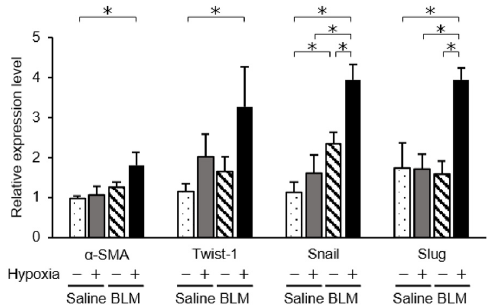
Figure 6. Expression of endothelial to mesenchymal transition markers determined by quantitative real-time PCR. mRNA levels of endothelial to mesenchymal transition markers were compared between endothelial cells from saline- and bleomycin-treated mouse lungs cultured under normoxic (20%) and hypoxic (1%) conditions. Quantitative real-time PCR was performed using three indepen- dently prepared cDNA samples from endothelial cells harvested from saline- or bleomycin-treated lungs on day 7. Results were normalized to expression levels in endothelial cells from untreated lungs at day 0. Data are means ± standard error of the mean for three mice. * p < 0.05.